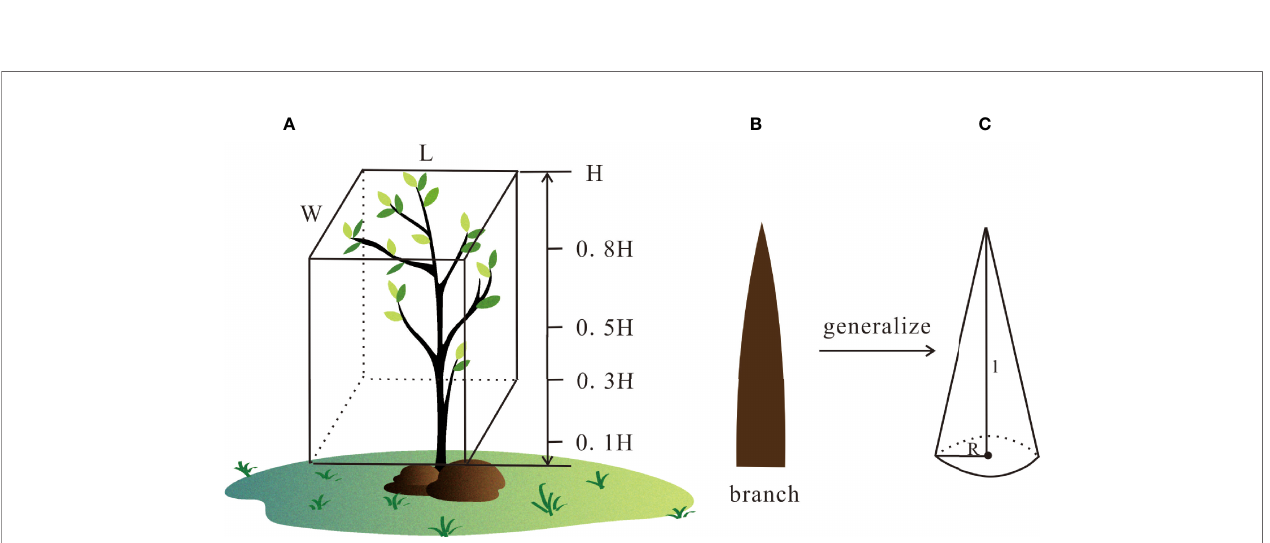
FIGURE 3 | Calculation method of the volumetric cover. (A) W, L, and H refer to the width, length, and height of the plant canopy; (B) a single branch extracted from Aegiceras corniculatum , which is generalized in (C) l and R refer to the length and radius of a single branch,